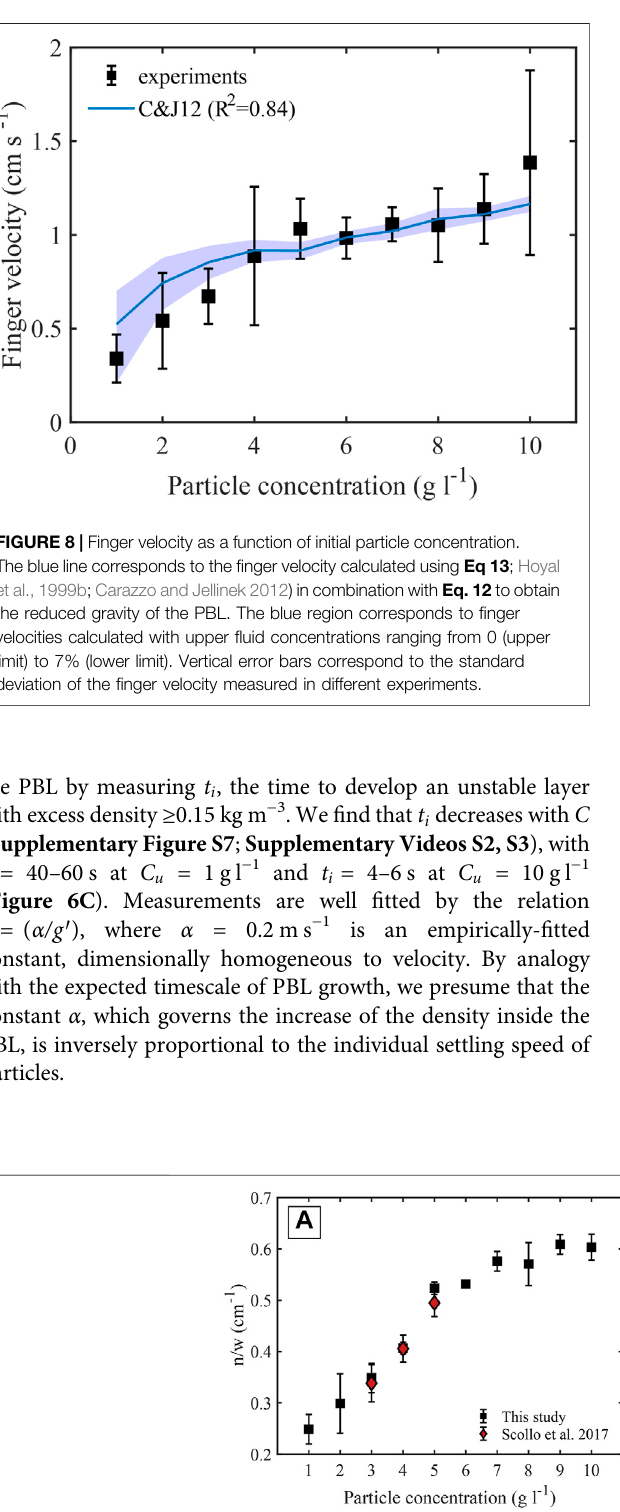
FIGURE 9 | (A) Variation in the number of fi ngers per unit length ( n / w ) as a function of particle concentration, with n the number of fi ngers and w the width of the experimental tank [ w (cid:2) 30.1 cm in this study and w (cid:2) 30.3 cm for Scollo et al. (2017)]. Vertical error bars correspond to the standard deviation of the number of fi ngers measuredindifferentexperiments. (B) Evolutionofthenumberof fi ngers perunitlengthasafunctionoftimeforselectedparticleconcentrations.Theuncertaintyof0.03 fi ngers cm − 1 comes from the typical discrepancy of ± 1 fi ngers determined by comparing the automatic detection of fi ngers with visual observations.